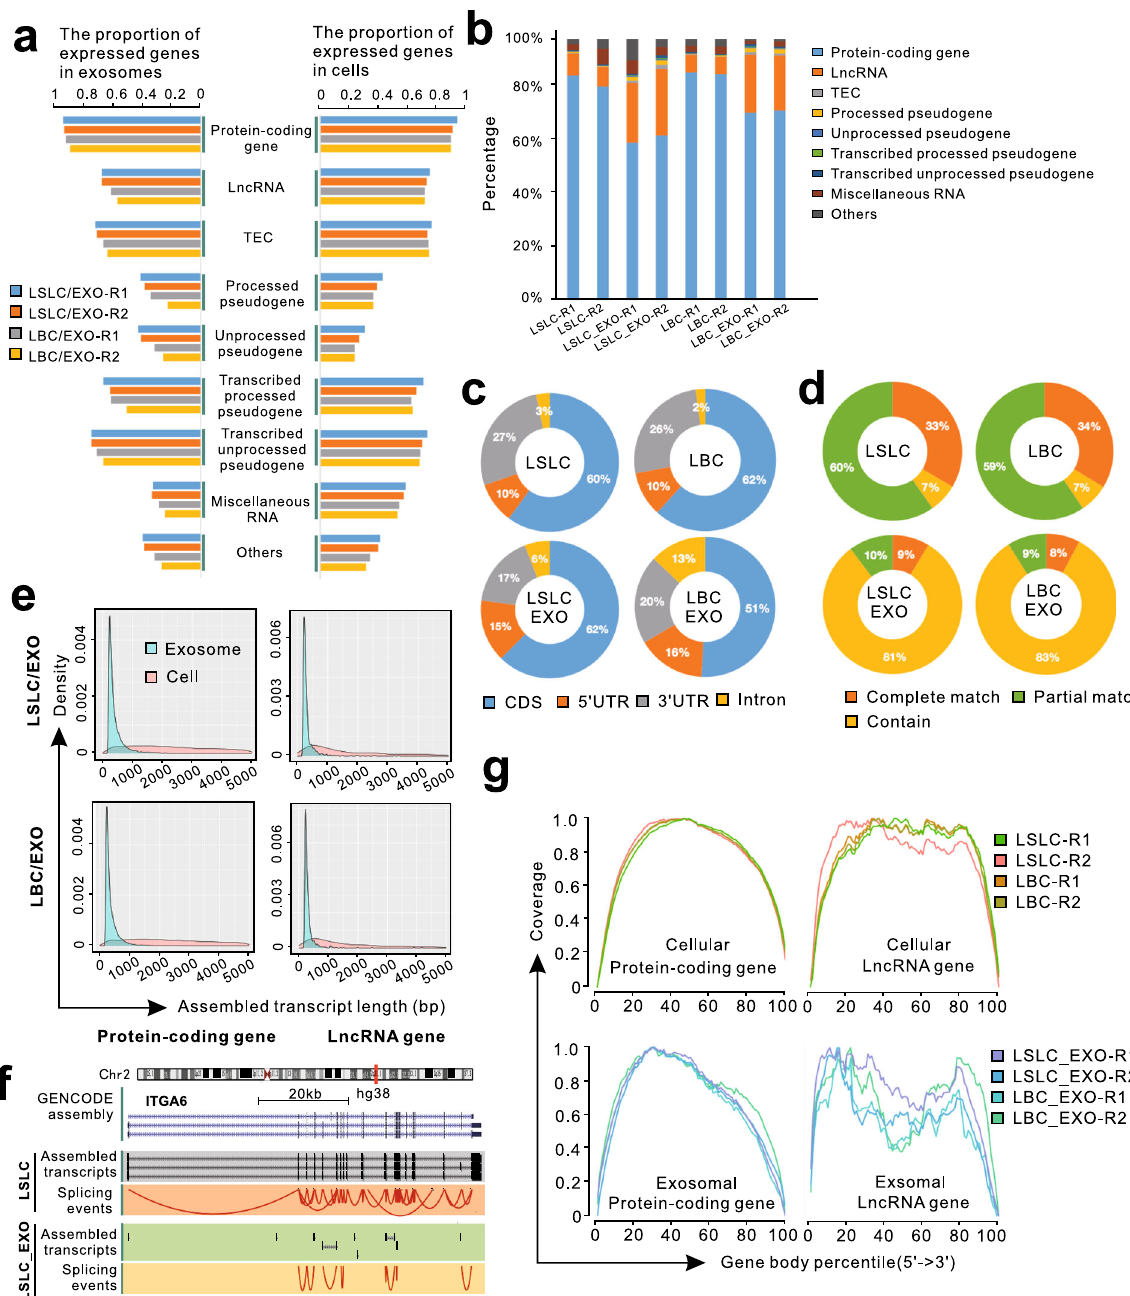
Fig. 3 Composition analysis of diverse RNA types in exosomes and their parental cells. a The proportion of each gene type identi fi ed in exosomes (left panel) and cells (right panel) at the transcriptomic level. b Normalized reads distribution of each gene type for each sample. c Percentage of RNA-seq reads mapping to exonic (CDS, 3 ’ UTR, and 5 ’ UTR for protein-coding gene) and intronic gene regions for cellular and exosomal samples. d The statistics of assembled transcripts that matched to reference protein-coding genes. e The length distribution of reference-matched transcripts assembled from exosomes and cells. f The genomic view and splicing events of ITGA6 gene. g The read coverage over gene 21,365 candidate circRNAs using CIRIquant algorithm that utilized the pseudo-reference alignment strategy and exhibited high performance in accurate circRNA identi fi cation and quanti fi ca- tion 42 . To further validate the reliability of our identi fi ed circRNAs, we compared them with human reference circRNAs annotated by circAltas 2.0 database 43 . The result showed that 71.7% (15,318/